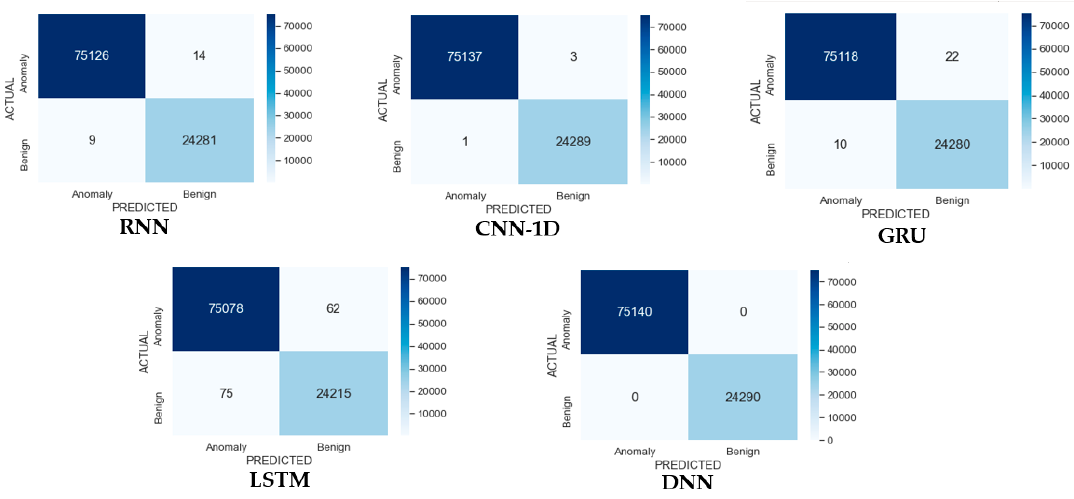
Figure 12. The confusion matrix of DL-NIDS methodology considering the top 05 features with MI > 0.5.